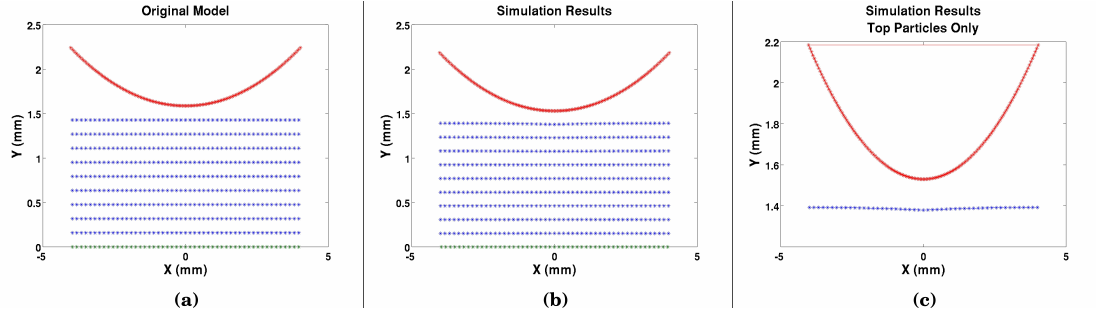
Figure 2. The disk-flat